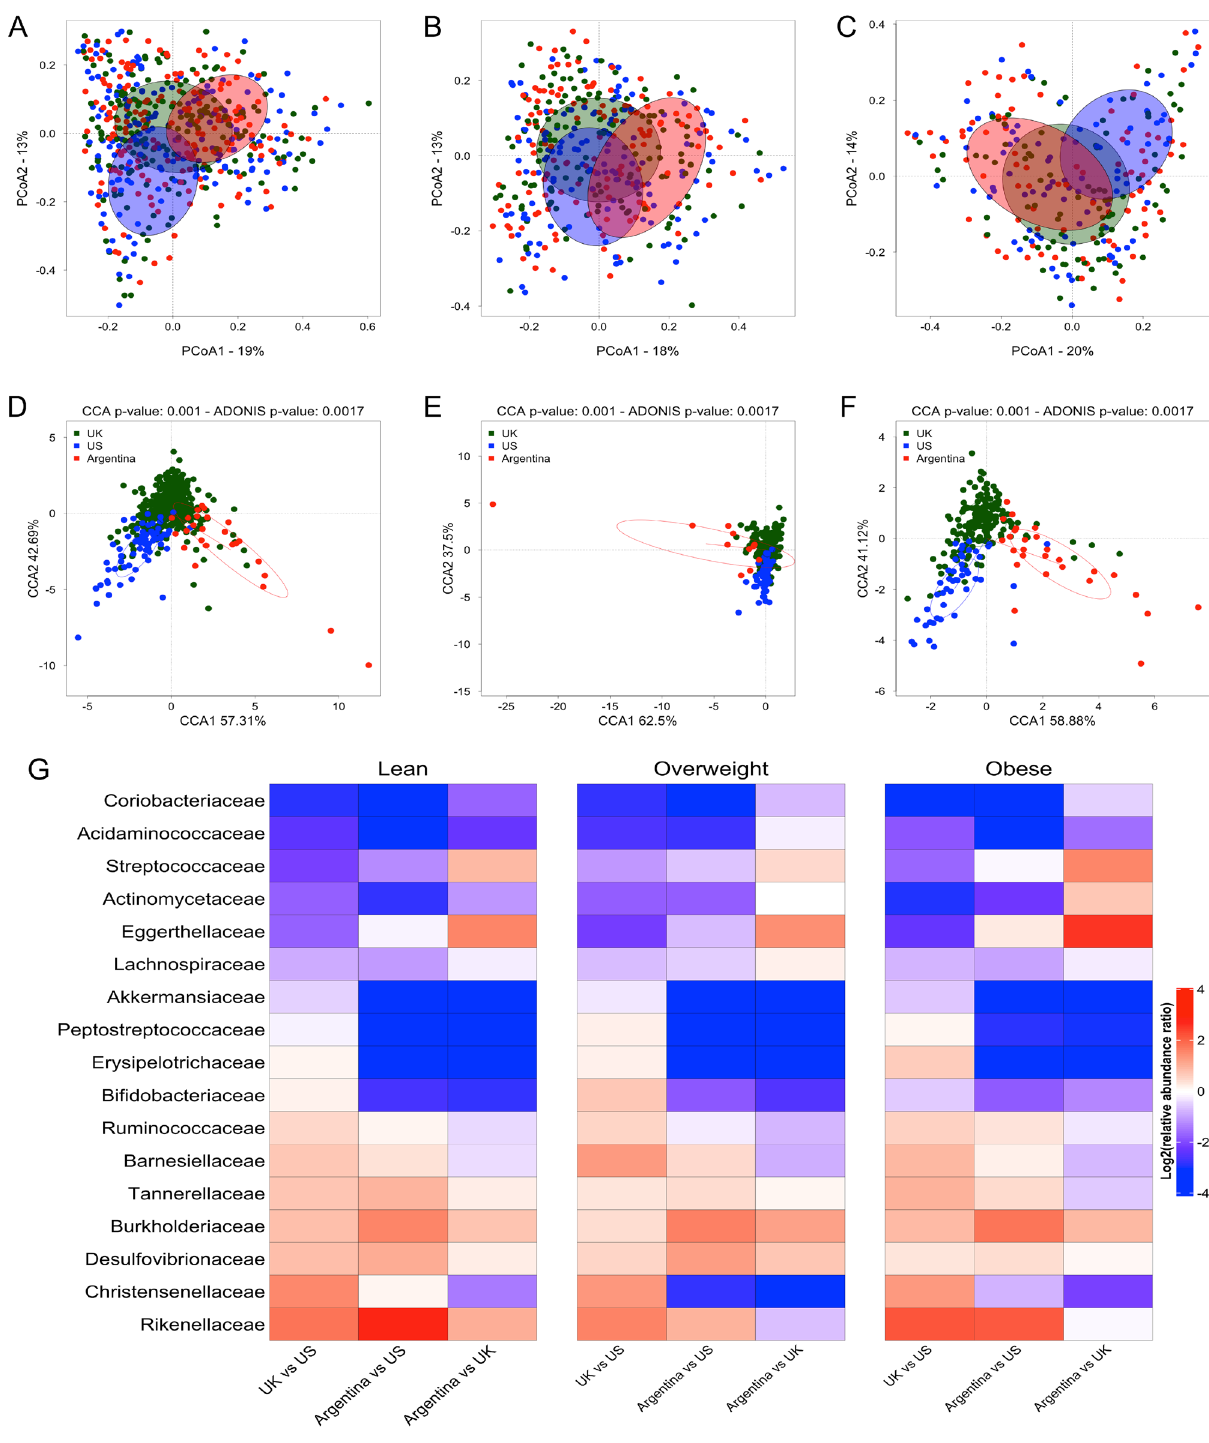
Figure 2. Differences in the microbiota composition among Argentinean, US and UK populations for each BMI group. ( A – F ) Comparison of microbiota profiles in Lean ( A , D ), Overweight ( B , E ) and Obese ( C , F ) using the Principal Coordinates Analysis (PCoA) ( A – C ) and the Canonical Correspondence Analysis method (CCA) ( D – F ) based on the Bray–Curtis distance. Each color represents a specific population (i.e. Argentine, UK and US). ( G ) Heat map representing the differential log2 (relative abundance ratio) changes of bacterial taxa common to the 3 groups, lean, overweight and obese, in populations of different geographic origins. Heatmap color (blue to dark red) displays the row scaled log2 (relative abundance ratio) of each